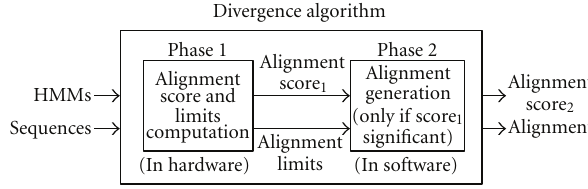
Figure 4: Phases of the Plan7-Viterbi-DA.